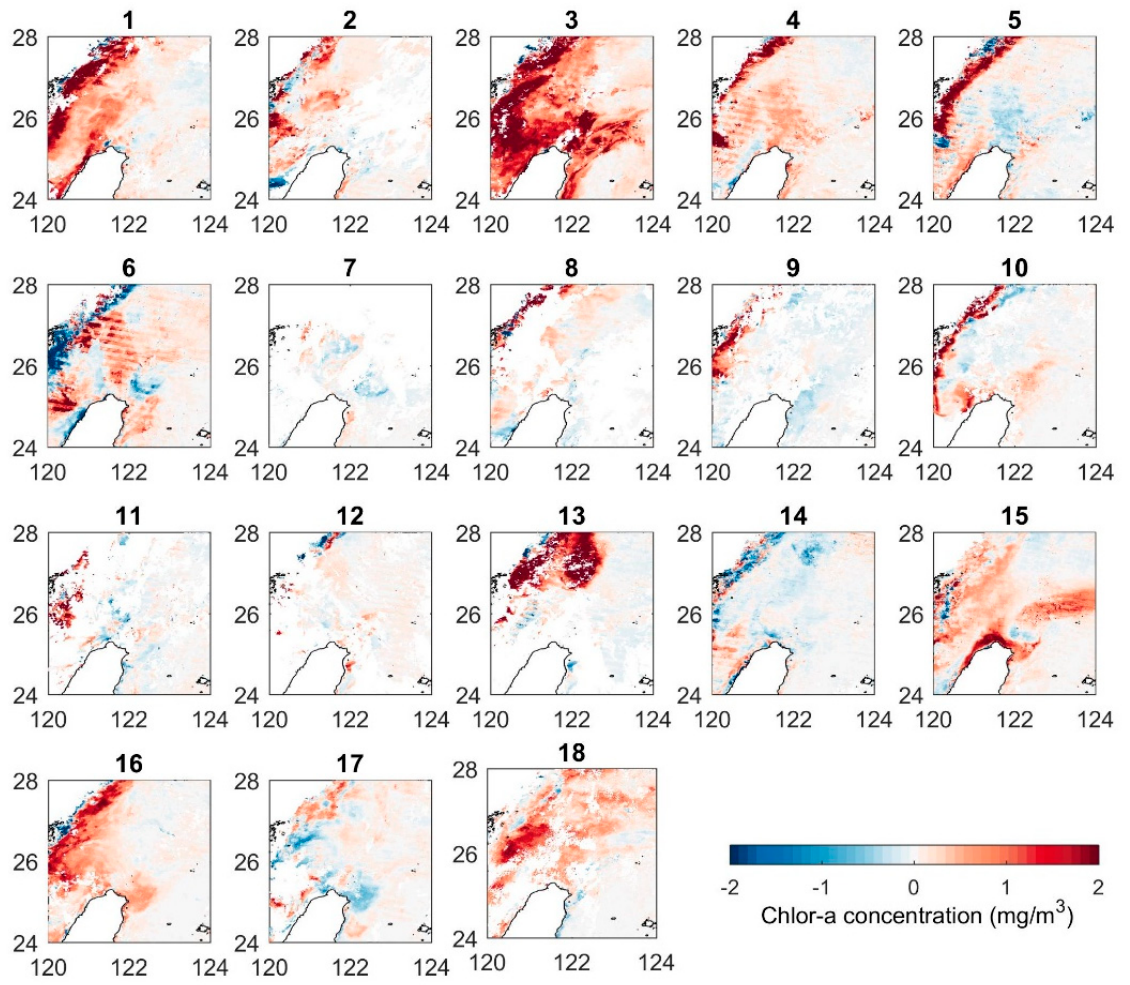
Figure 7. Di ff erence between poststorm and prestorm Chl-a concentration (mg / m 3 , one-week composite Figure 7. Difference between poststorm and prestorm Chl-a concentration (mg/m 3 , one-week images) for the 18 typhoons shown in Figure composite images) for the 18 typhoons shown in Figure 2.